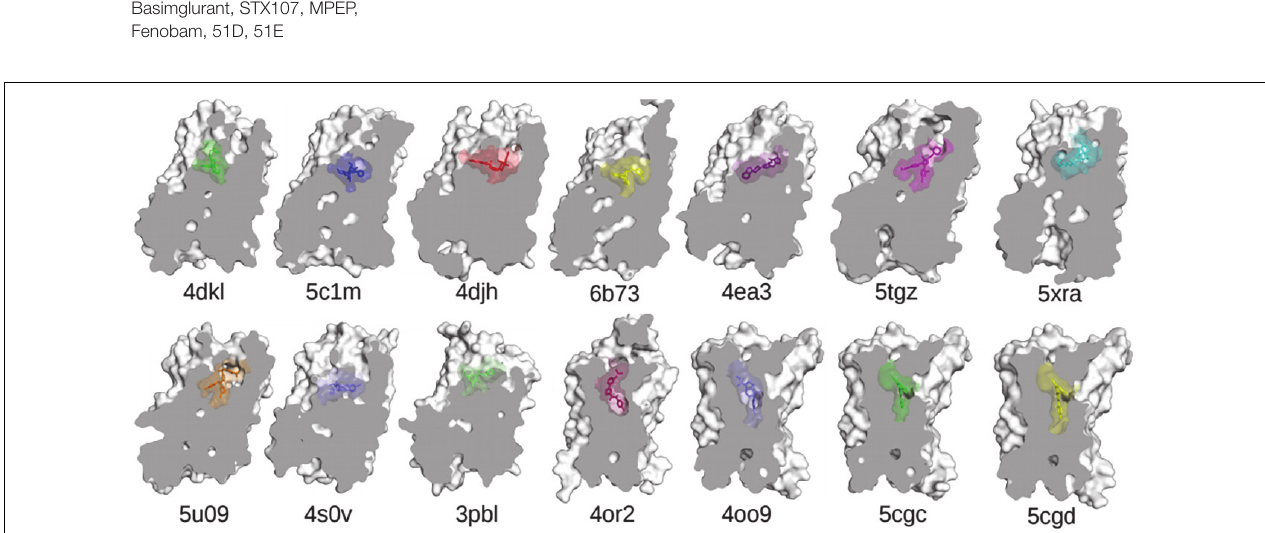
FIGURE 3 | The experimentally determined high-resolution GPCR structures, together with their bound ligands, used in the MD-based studies discussed in this review. Nanobodies and other interacting proteins were removed. PDB 4dkl, The antagonist β -FNA bound to the MOP receptor; PDB 5c1m, The agonist BU72 bound to the MOP receptor; PDB 4djh, The antagonist JDTic bound to the KOP receptor; PDB 6b73, The agonist MP1104 bound to the KOP receptor; PDB 4ea3, The peptide mimetic antagonist compound 24 bound to the NOP receptor; PDB 5tgz, The antagonist AM6538 bound to the CB1 receptor; PDB 5xra, The agonist AM11542 bound to the CB1 receptor; PDB 5u09, The inverse agonist taranabant bound to the CB1 receptor; PDB 4s0v, The antagonist suvorexant bound to the OX2 receptor; PDB 3pbl, The antagonist eticlopride bound to the D3 receptor; PDB 4or2, The negative allosteric modulator FITM bound to the transmembrane domain of mGluR1; PDB 4oo9, The negative allosteric modulator mavoglurant bound to the transmembrane domain of mGluR5; PDB 5cgc, The negative allosteric modulator 3-chloro-4-fluoro-5-[6-(1H-pyrazol-1-yl)pyrimidin-4-yl]benzonitrile bound to the transmembrane domain of mGluR5; PDB 5cgd, The negative allosteric modulator 3-chloro-5-[6-(5-fluoropyridin-2-yl)pyrimidin-4-yl]benzonitrile bound to the transmembrane domain of mGluR5.